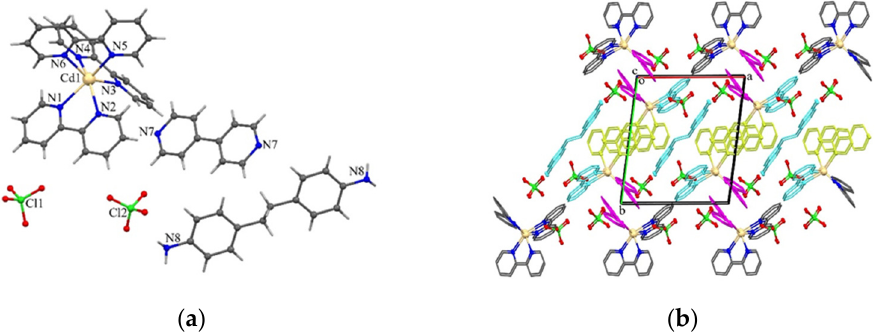
Figure 2. Compound 1 . ( a ) View of components in 1 with partial labelling scheme. ( b ) Fragment of crystal packing with stacking patterns colored magenta for 2,2 ′ -bpy/2,2 ′ -bpy dimer; yellow for 2,2 ′ -bpy/4,4 ′ -bpy/2,2 ′ -bpy trimer; and cyan for 2,2 ′ -bpy/dadpe/2,2 ′ -bpy trimer.